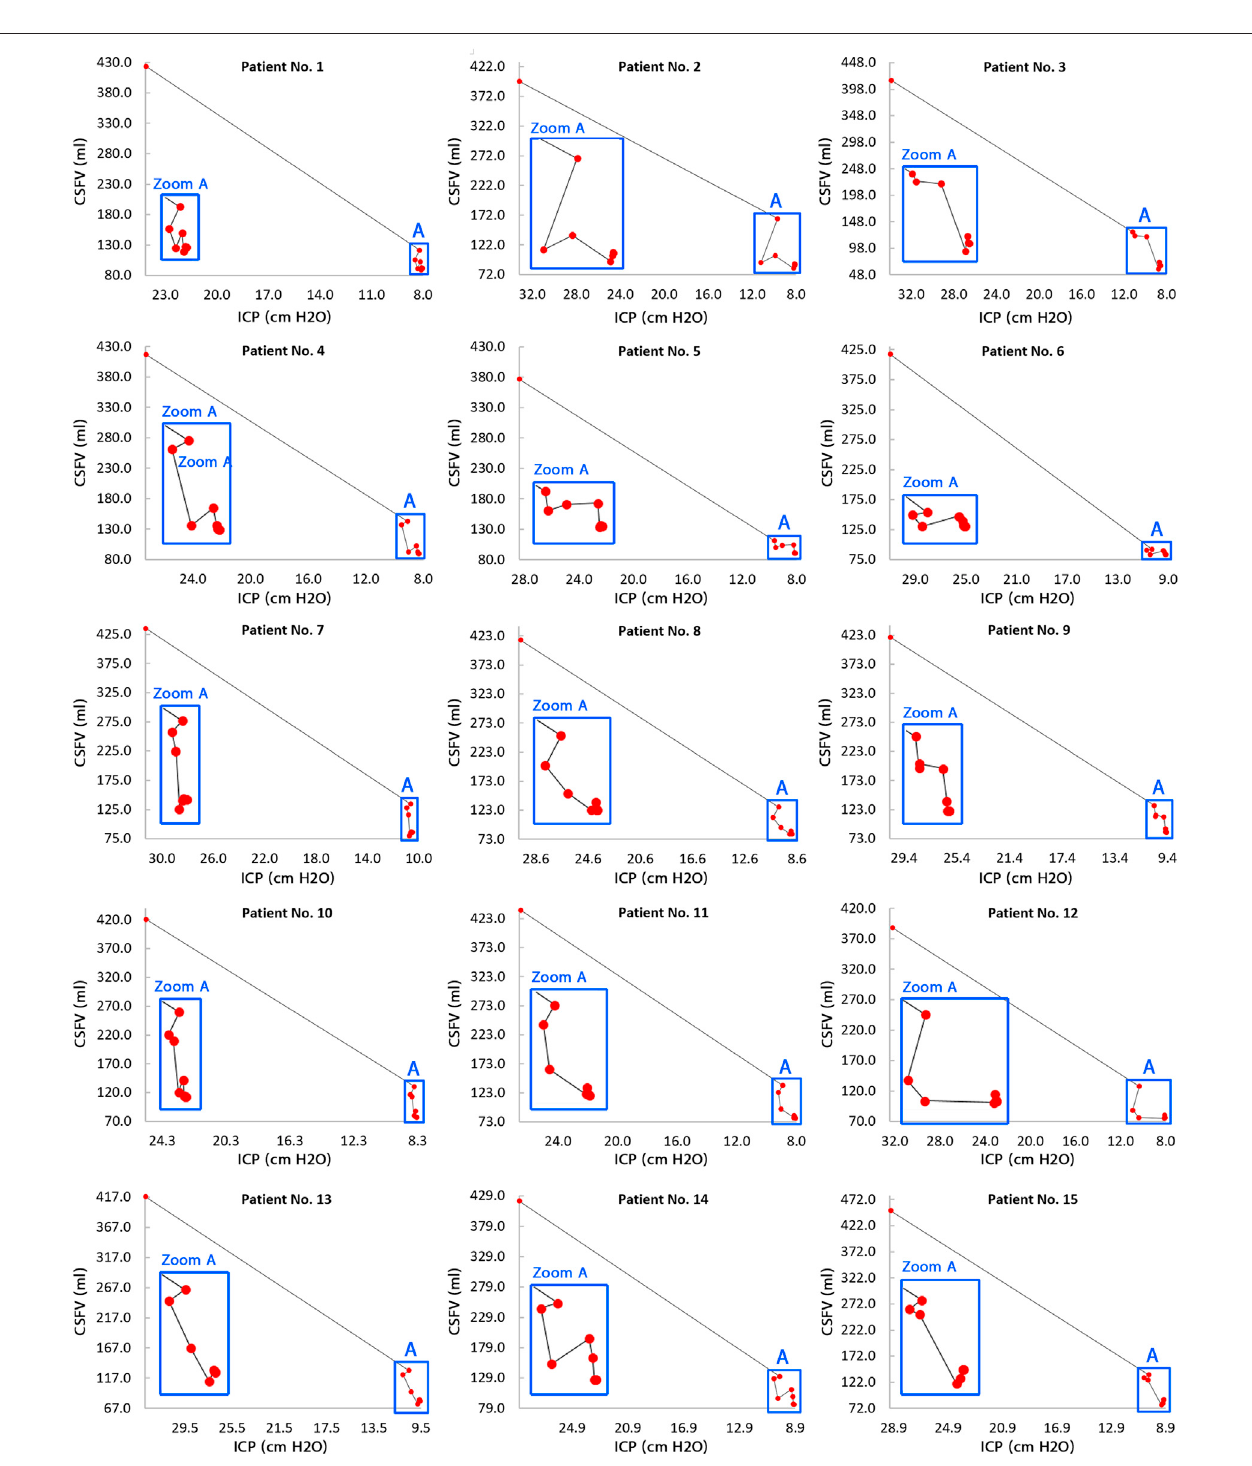
FIGURE 5 | CSFV – ICP graphs for all 15 patients. The general trend of the CSFV – ICP graphs in all 15 patients was not monotonic. The slopes of these graphs are representative ofthe long-term ICC changes during shunttreatment.There are 9red circles in each panel witheach circle representingastep.The steps include priorto shunting,and1,2,3,6,9,12,15,and18 monthsaftershunting.Ineachpanel,the fi rstredcircleontheleftsiderepresentspriortoshunting,andthelastredcircleonthe right siderepresents 18 months after shunting;hence, moving from the left to theright shows theprogression ofthe treatment process. Rawdata for Figure 4 are included in Supplementary Tables S1 and S3 . CSFV: cerebrospinal fl uid volume; ICP: intracranial pressure; and ICC: intracranial compliance.